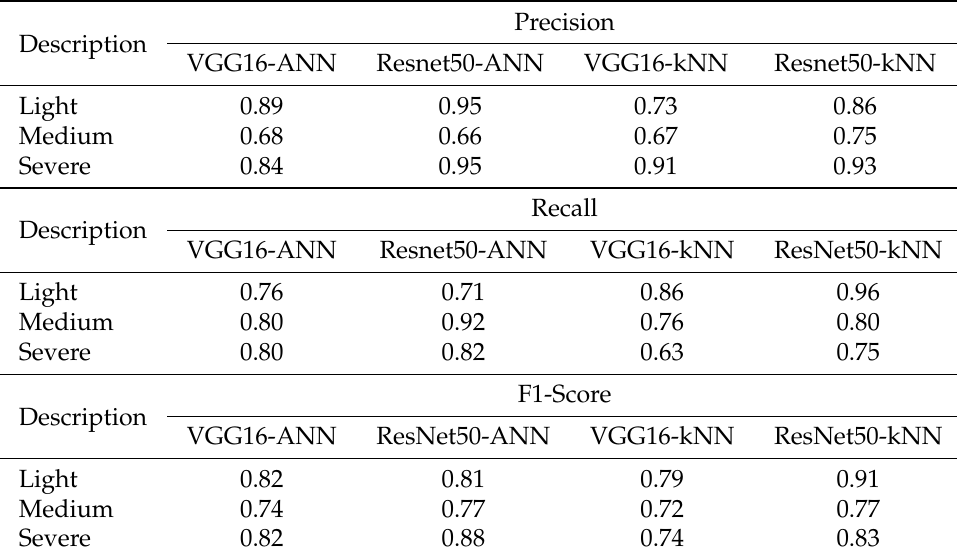
Table 5. Classification performance of four models in test 2 using greyscale dataset.